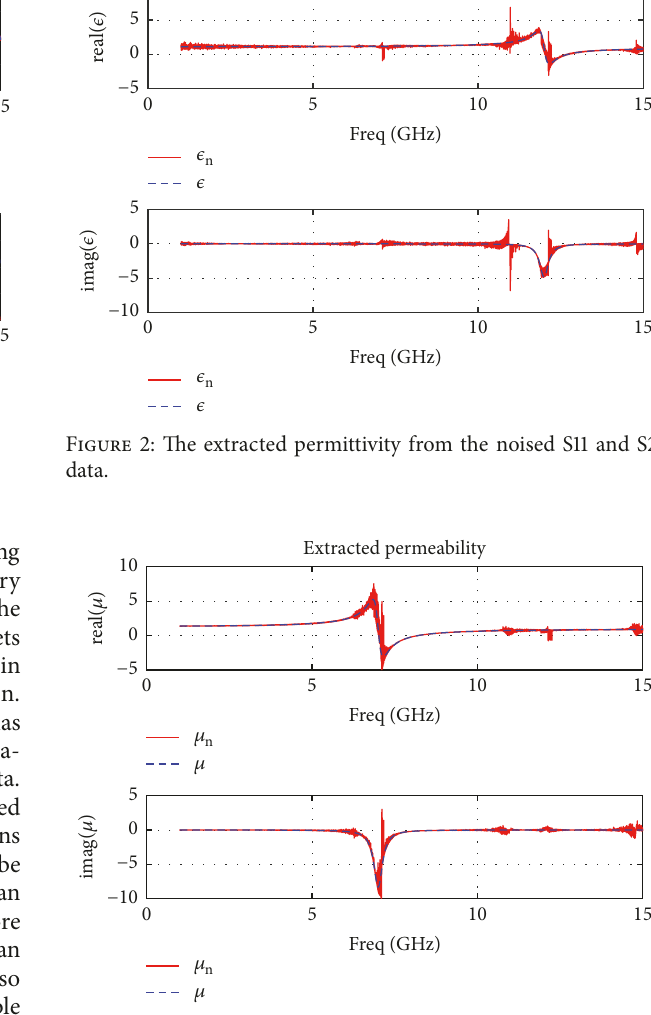
Figure 3: The extracted permeability from the noised S11 and S21